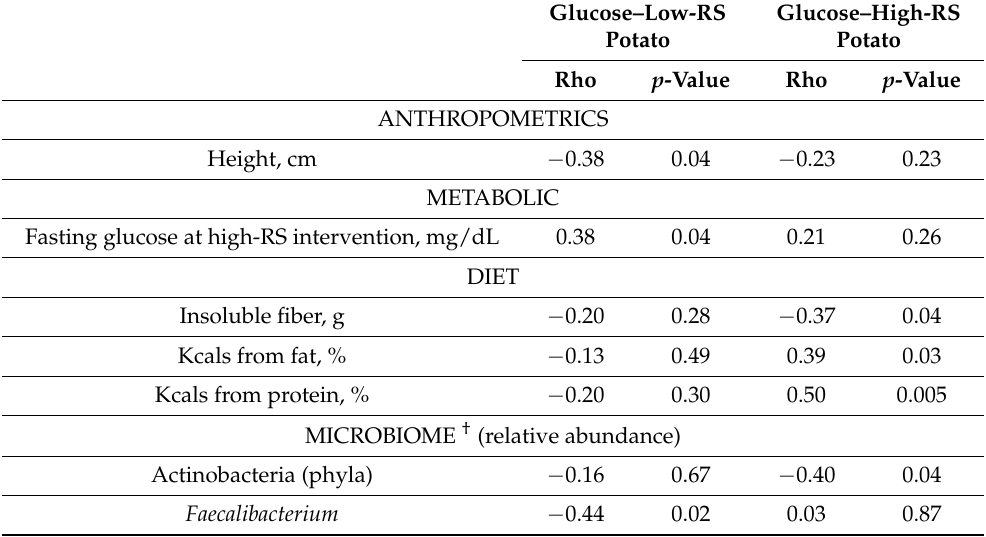
Table 3. Significant * correlations between baseline characteristics and iAUCs of glucose, Spear- man’s rho.